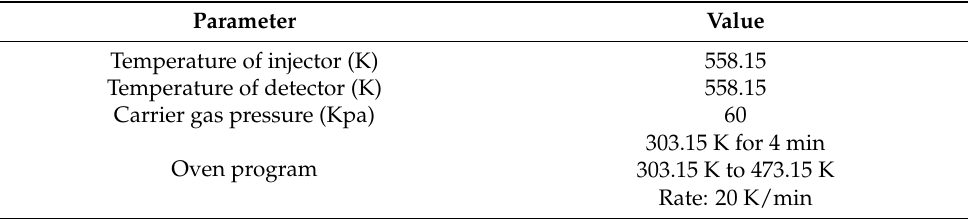
Table 2. Gas chromatography operating conditions.